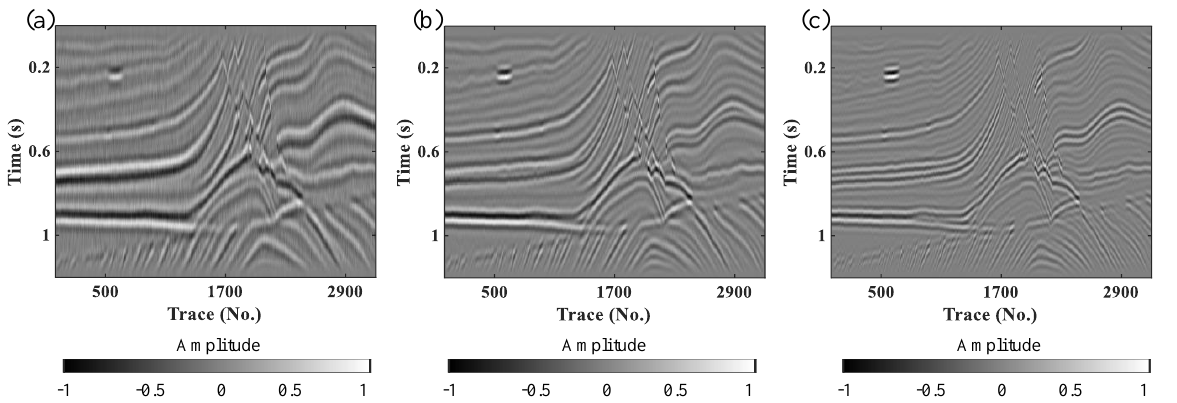
Figure 5. Multi-scale seismic data: ( a ) Low frequency data. ( b ) Medium frequency data. ( c ) High frequency data.